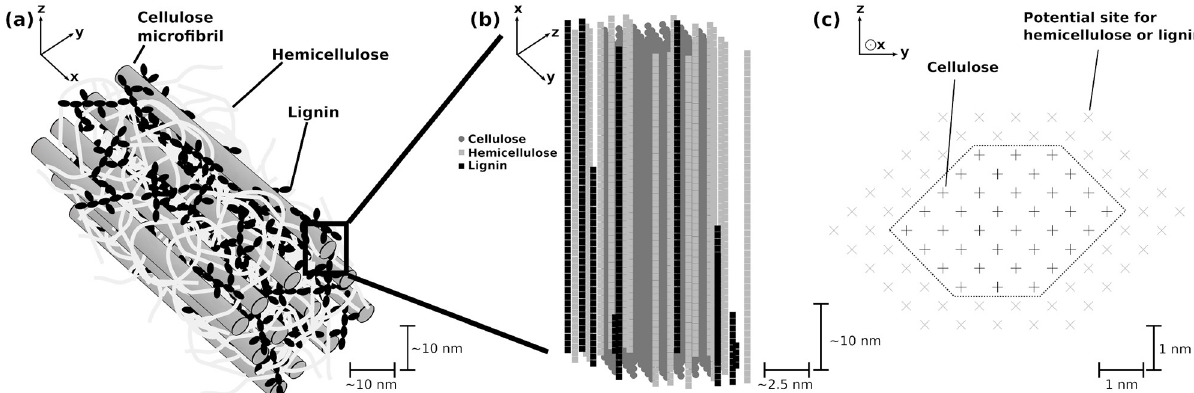
Fig 1. Schematic representation of the structure of the substrate in the model. (a) Several cellulose microfibrils embedded in a matrix of hemicellulose reinforced by lignin. (b) Side-view of the top 50 nm of a single cellulose microfibril made of 36 polymers, and part of the surrounding matrix showing the relative arrangement of the hemicellulose and lignin polymers as well as gaps. In (a) and (b), polymer types are color-coded (cellulose: dark gray; hemicellulose: light gray; lignin: black). (c) Top-down view of the structure shown in (b). The core enclosed by the dotted line is composed of 36 polymers of cellulose (black crosses), and its structure follows that used by Ding et al. [57]. The positions in the two outer layers (gray crosses) can each either be hemicellulose or lignin polymers.